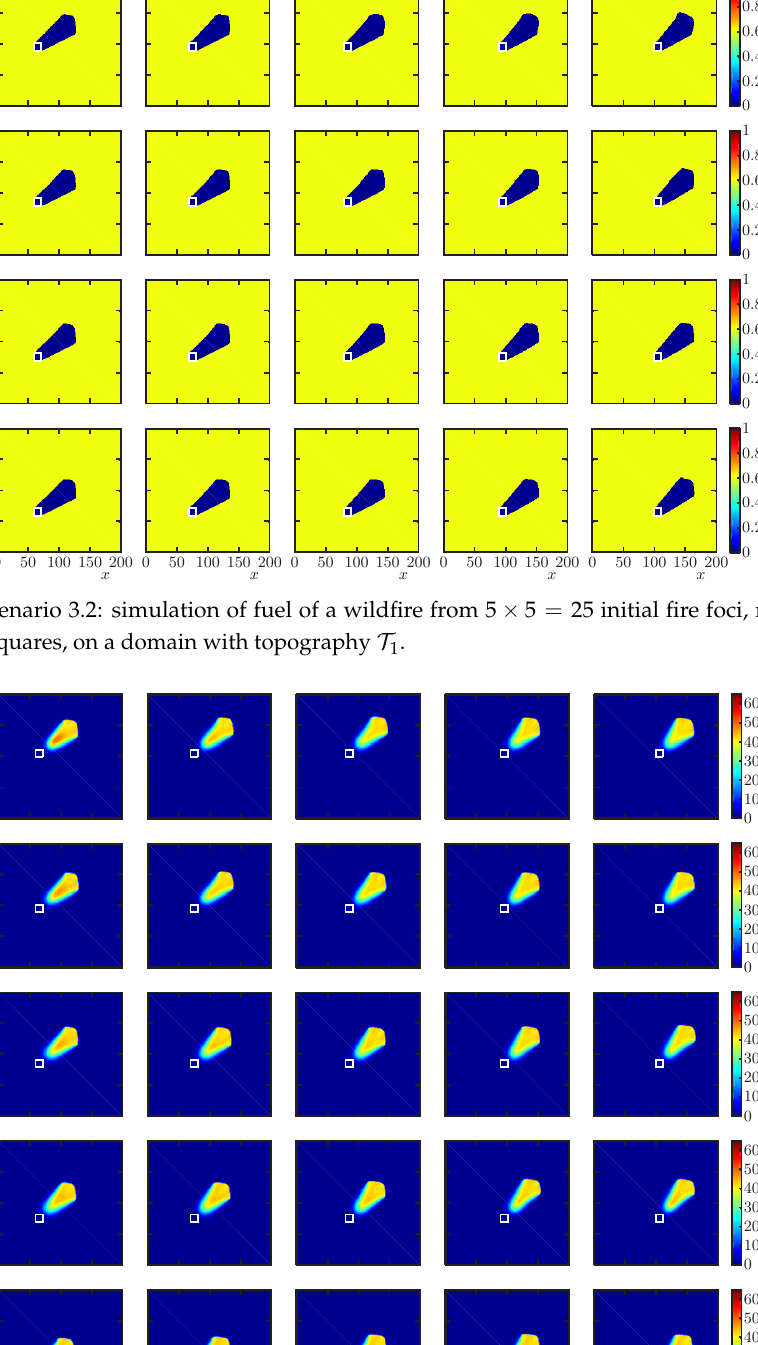
Figure 11. Scenario 3.3: simulation of temperature of a wildfire from 5 marked by small white squares, on a domain with topography